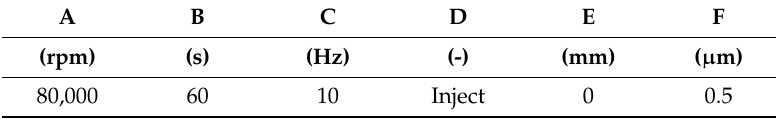
Table 5. Optimization results for machining the AISI 304 surface roughness.